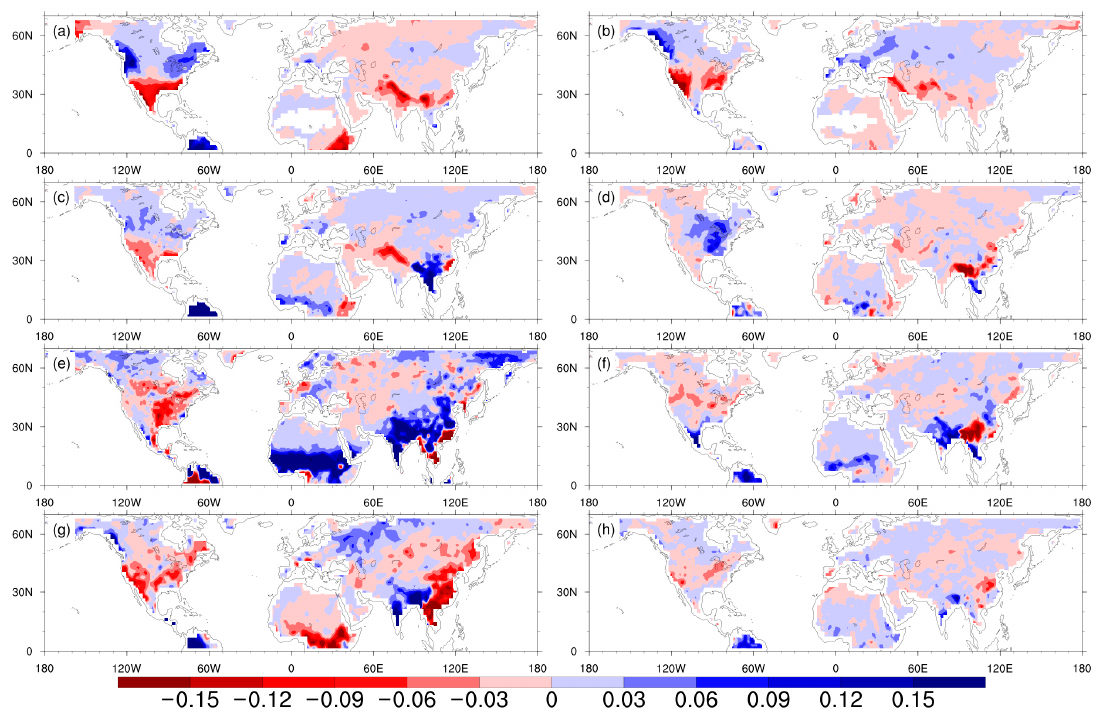
Figure 6. Averages of the spatial distributions of the leading EOF from (left) good models and (right) poor models in ( a , b ) winter, ( c , d ) spring, ( e , f ) summer, and ( g , h ) autumn. Unit: mm/day.